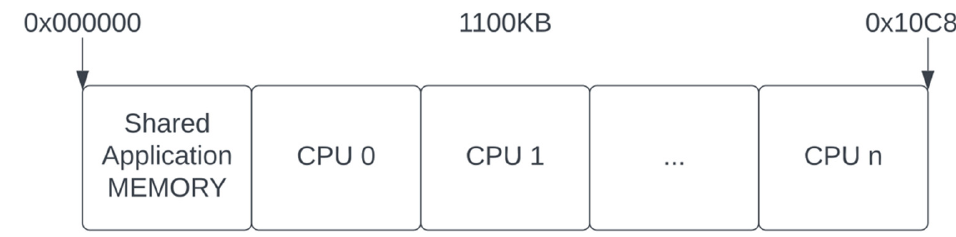
Figure 15. The mechanism of memory assignment.